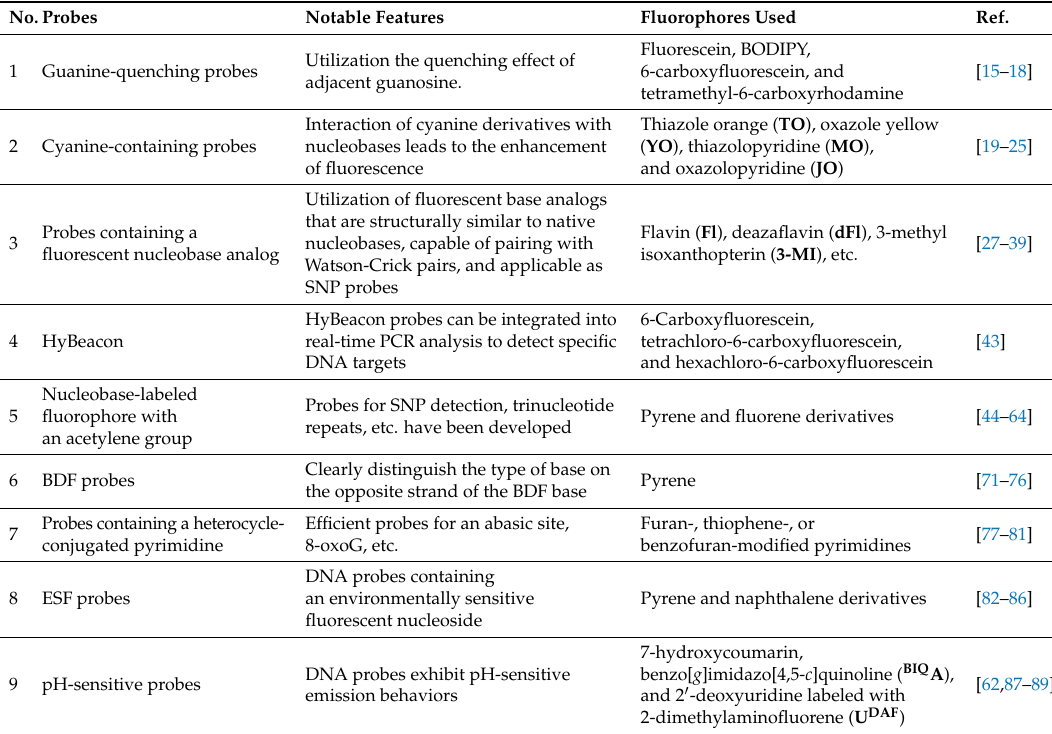
Table 2. Single-labeled oligonucleotide